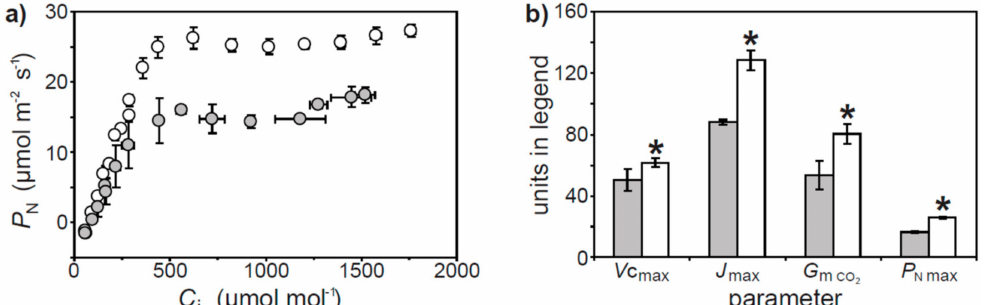
Figure 2. The relationship between photosynthesis ( P N ) and stomatal conductance to water vapor ( G s H2O ) ( a ), and stomatal ( G s CO2 ) ( b ), mesophyll ( G m CO2 ) ( c ) and total ( G tot CO2 ), ( d ) conductance to CO 2 of olive plants during (square symbols, dashed best fit line) and after (circle symbols, solid best fit line) the heat wave (marked in light grey shading in Figure 1) subject to full irrigation (white fill symbols) and water deficit (grey fill symbols) treatment.